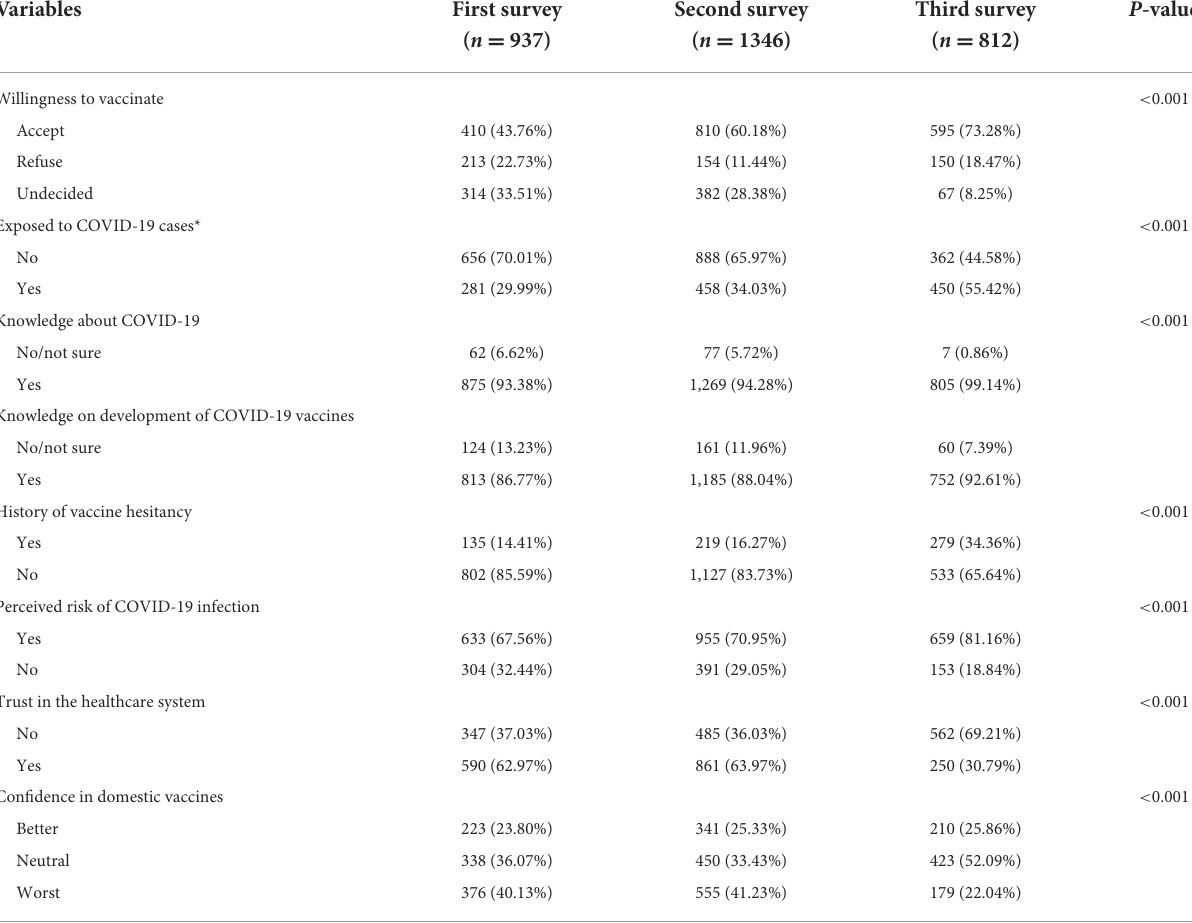
TABLE 2 Change over time in willingness to accept COVID-19 vaccine among healthcare worker during first and second wave of COVID-19